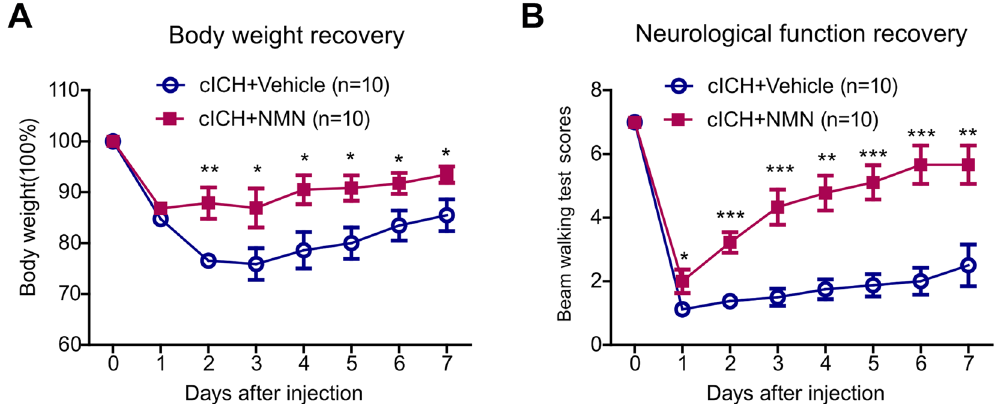
Figure 8. Effects of a 7-day treatment of NMN on body weight and neurological function recovery in mouse cICH model. Mice were treated with saline (control) or NMN (first dose at 30 minutes post cICH from tail vein [300 mg/kg] and subsequent dose by intraperitoneal injection for 7 days post cICH [300 mg/kg]). ( A ) Body weight curve. ( B ) Neurological score curve. n = 10 per group. * P < 0.05, ** P < 0.01, *** P < 0.001 cICH + NMN vs cICH +